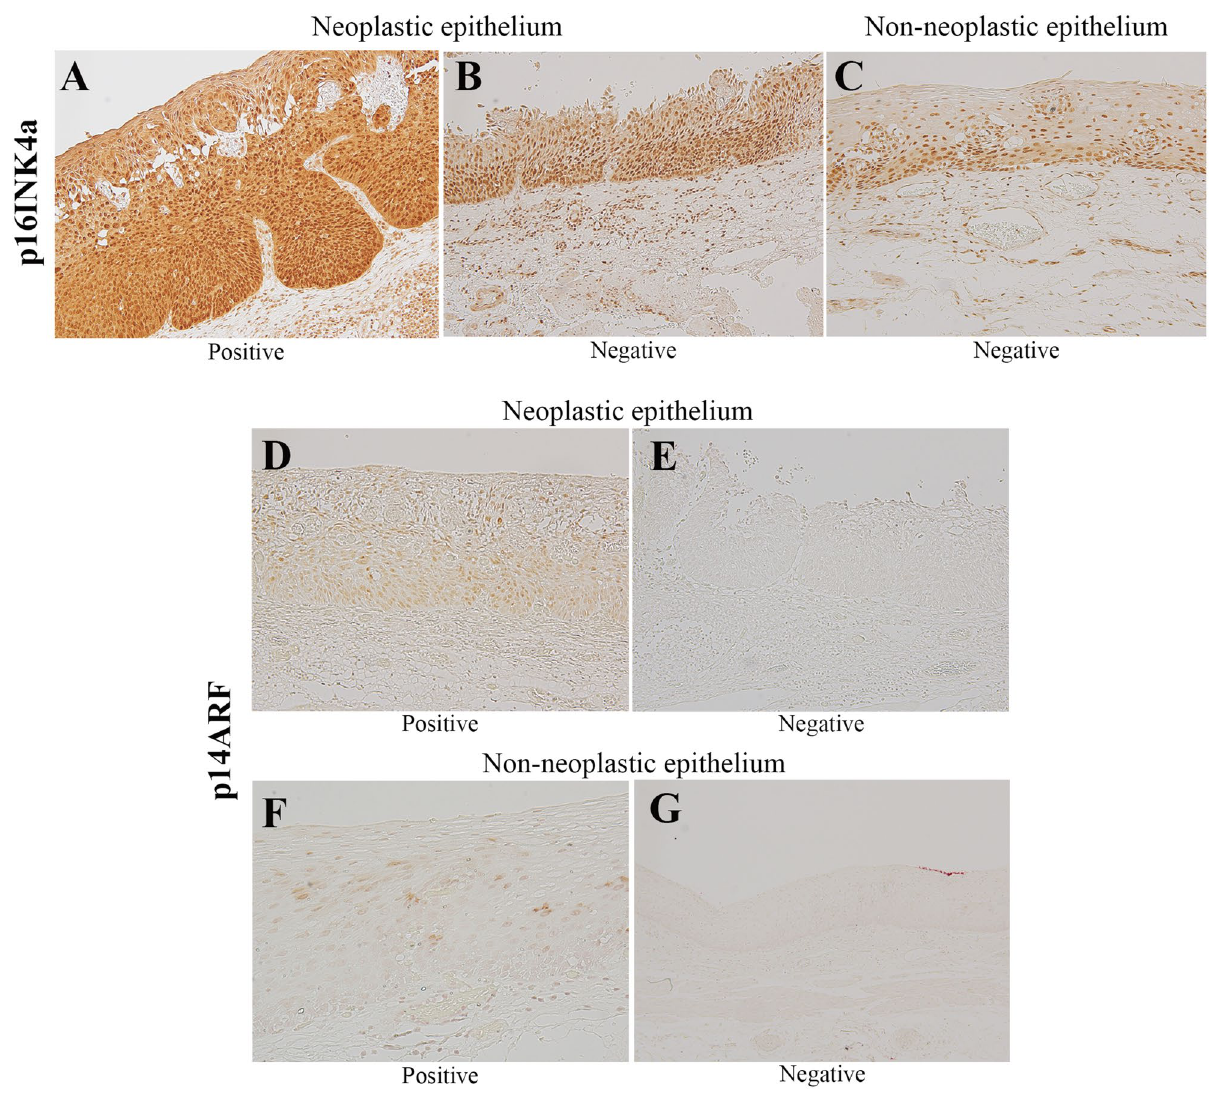
Figure 3. Representative immunohistochemical images of p16INK4a and p14ARF. Both the nucleus and cytoplasm were stained in p16INK4a-positive neoplastic epithelium ( A ); in contrast, in the p16INK4a-negative neoplastic epithelium, the cytoplasm was unstained ( B ). In all patients, no cytoplasmic p16INK4a-positive images were observed for the non-neoplastic epithelium ( C ). The nucleus was stained in p14ARF-positive neoplastic epithelium ( D ); in contrast, in the p14ARF-negative neoplastic epithelium, the nuclei were unstained ( E ). Patients for whom the non-neoplastic epithelium stained for p14ARF in the nucleus were considered positive ( F ), and those for whom this staining was not observed were considered negative ( G ). In both neoplastic and non-neoplastic epithelium, the expression of p16INK4A in the cytoplasm and p14ARF in the nucleus (> 10%) were considered positive. p14ARF p14 alternate reading frame; p16INK4a p16 inhibitor of cyclin-dependent kinase 4A.